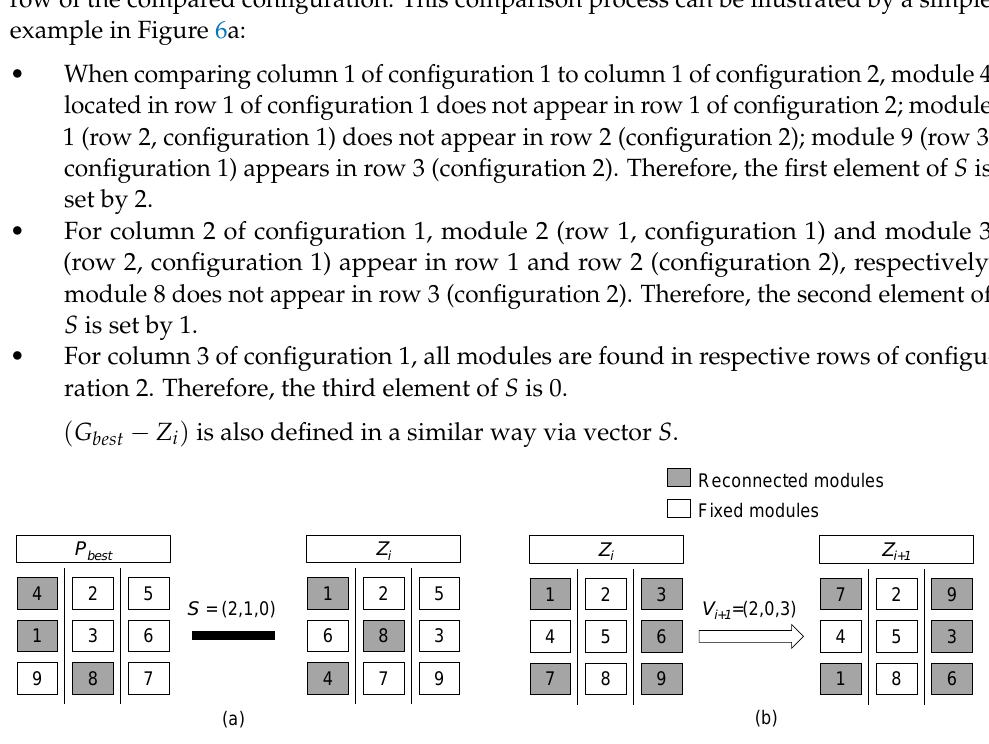
Figure 6. ( a ) Example on comparing two PV configurations. ( b ) Example on updating PV